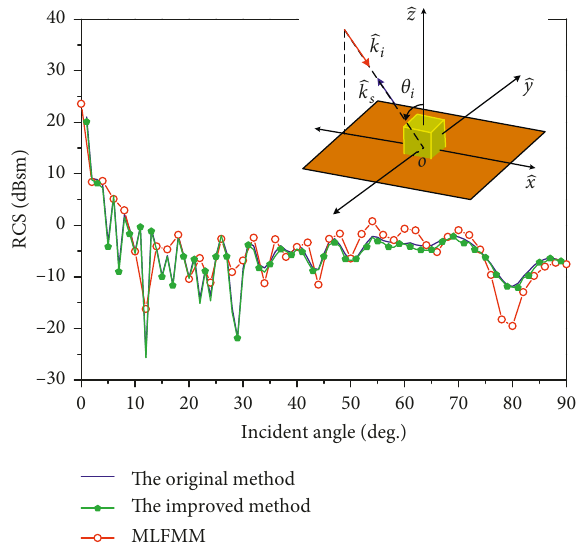
Figure 6: The validation of the improved kd-tree accelerated method in this